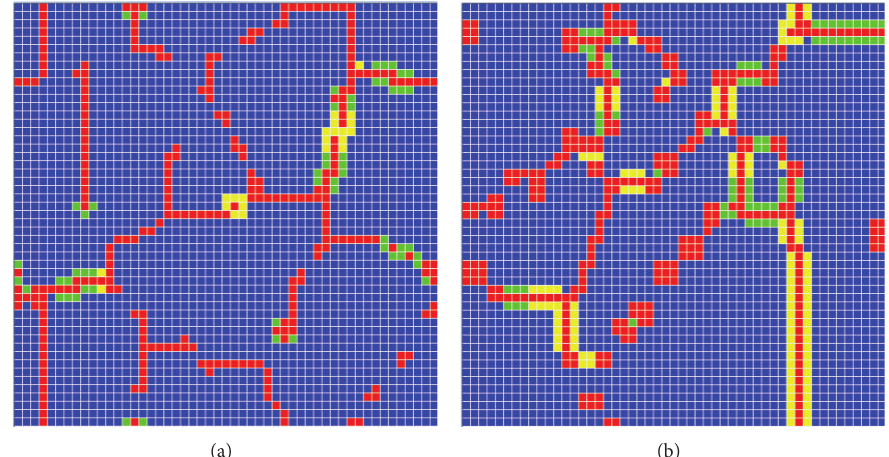
Figure 11: Simulation results on a 50 × 50 square lattice with Moore neighborhood and self-playing. The initial distribution of cooperators and defectors is randomly generated. The pattern in (a) is performed by the parameters region 𝑢 1 0 > 𝑢 3 1 , 𝑢 2 0 > 𝑢 4 1 , 𝑢 𝑖 0 < 𝑢 𝑖+2 1 (𝑖 = 3, 4, . . . , 6) , and the pattern in (b) is by the region 𝑢 5 0 > 𝑢 7 1 , 𝑢 6 0 > 𝑢 8 1 , 𝑢 𝑖 0 < 𝑢 𝑖+2 1 (𝑖 = 1,2,...,4) .